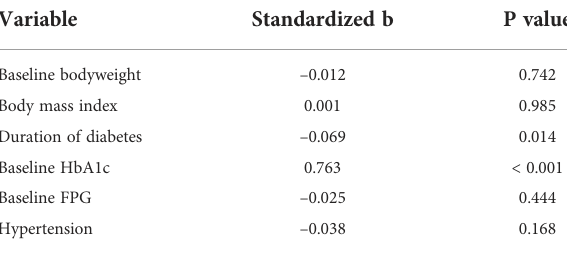
TABLE 5 Multiple linear regression analysis of HbA1c reduction after dulaglutide